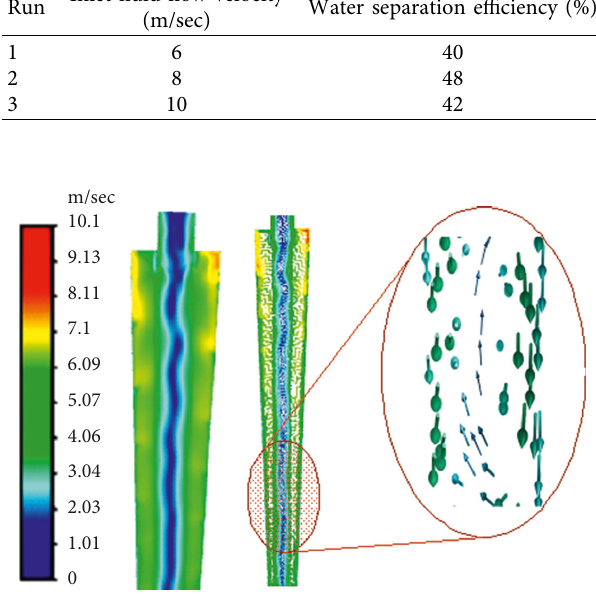
Figure 10: The fluid flows vectors inside the hydrocyclone. Table 5: The effect of water droplet diameter on the separation efficiency.